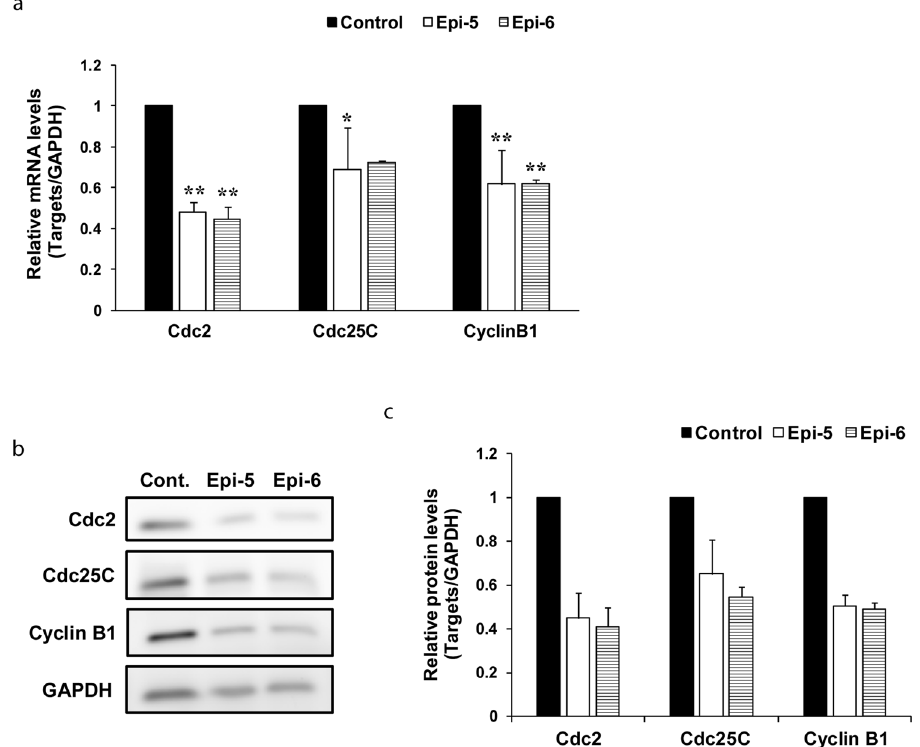
Figure 6. Effects of test compounds on the expression of the cell cycle-related genes. Cells were cultured as described in Biochemical methods and treated with ethanol (6% v/v) alone (control) and 50 μ mol/L test compounds. The experimental procedure for preparation of test compounds was described in Biochemical methods of Supplementary Information. ( a , b , c ). Test oligomeric compounds, epicatechin pentamer (Epi-5) and epicatechin hexamer (Epi-6) significantly suppressed the expression of Cdc2, Cdc25C and Cyclin B1 at mRNA and protein levels in PC-3 cells. The cells treated with test compounds for 48 h were collected and the mRNA level was determined by qPCR ( a ). Whole cell lysates were prepared and subjected to western blotting. Western blot analysis of protein levels (Cdc2, Cdc25C and Cyclin B1) was determined after treatment of PC-3 cells with epicatechin pentamer (Epi-5) and hexamer (Epi-6) ( b , c ). The data of Western blot analysis are representative of three independent experiments. The quantification of these protein levels by densitometric measurement using Image J software (NIH) ( c ). The data of qPCR and densitometric data from western blot analysis are the means ± S.D. of three independent experiments, and one-way ANOVA followed by Tukey’s multiple comparison test was used to compare means. * P < 0.05 or ** P <